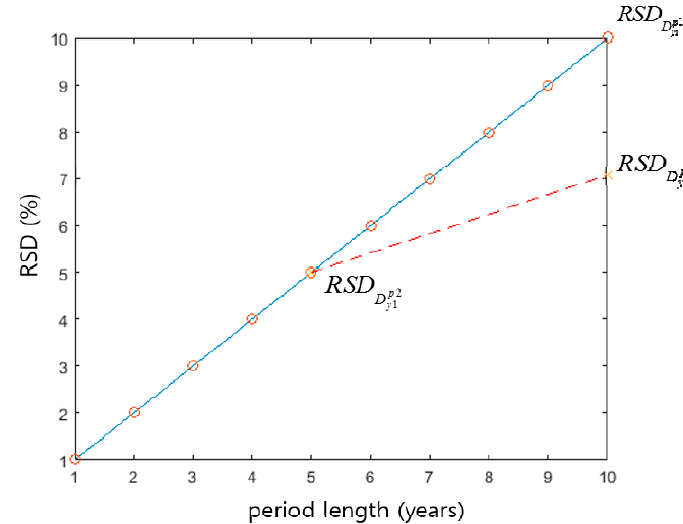
Figure 5. Estimated RSD curve and calculated RSD values.